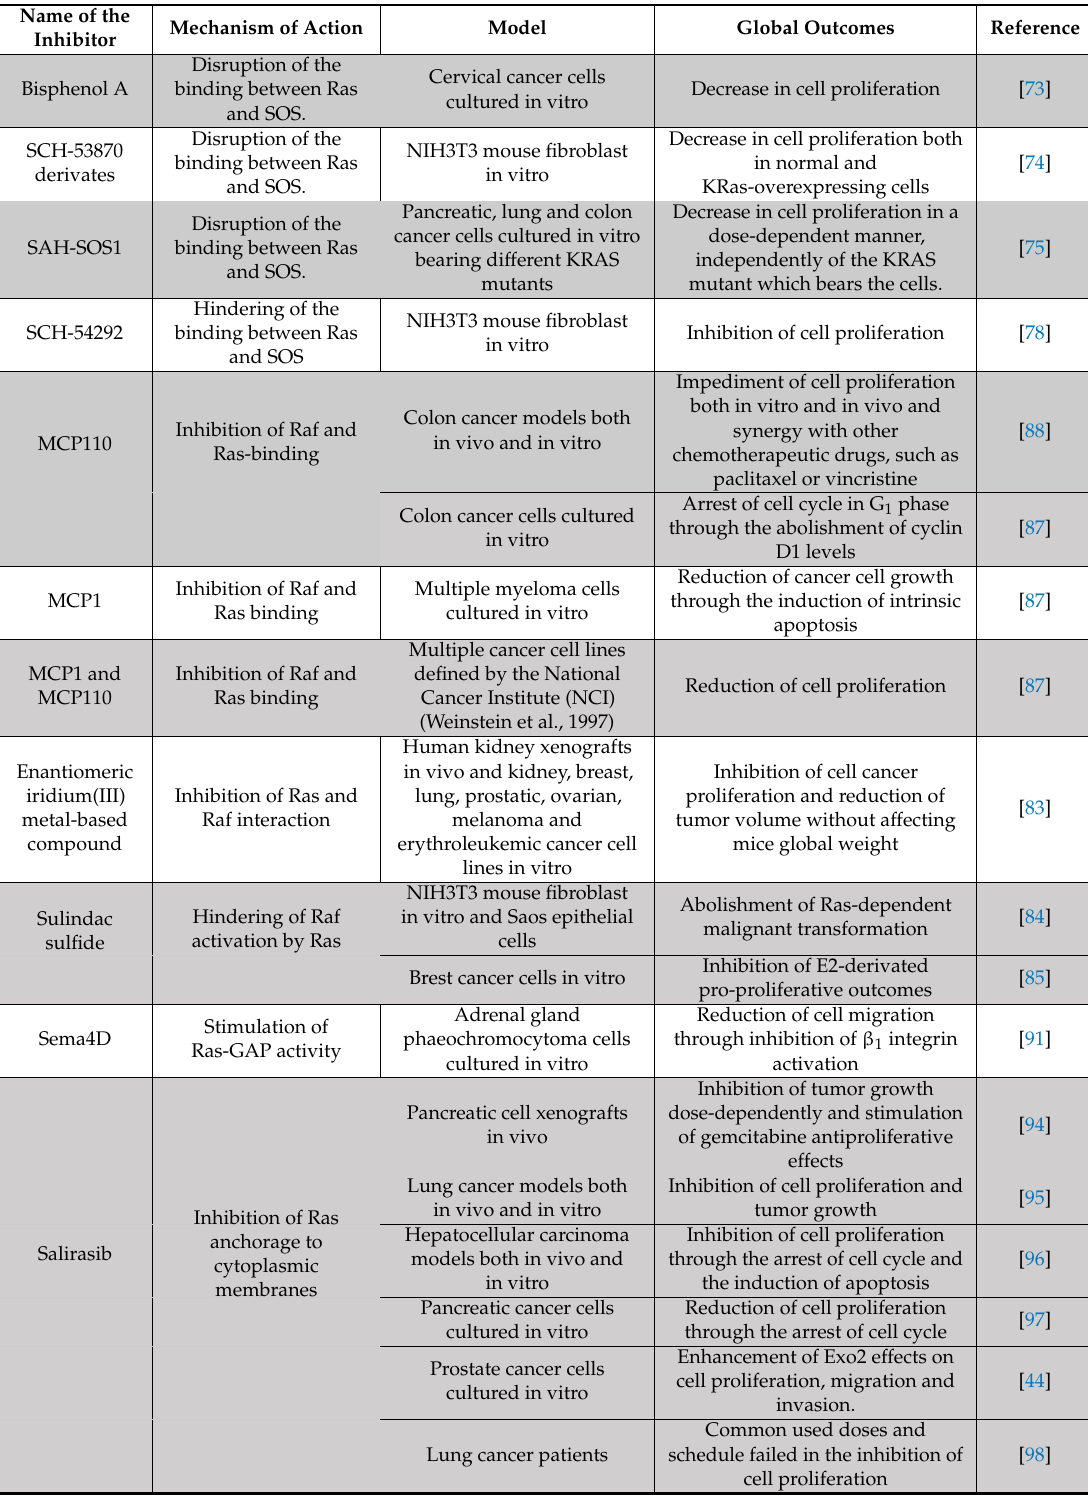
Table 2. Action of Ras inhibitors in cancer